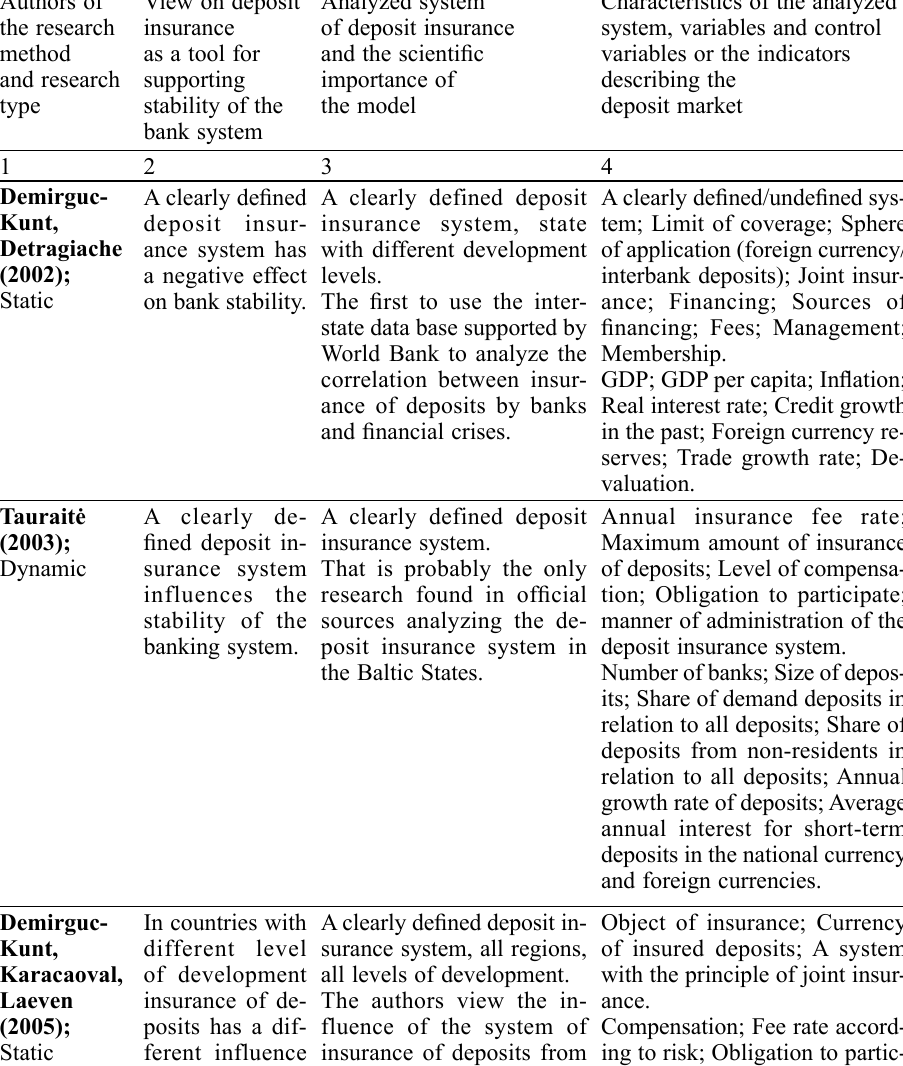
Table 1. Supporters of research on the in (cid:192) uence of insurance of deposits on the stability of the banking